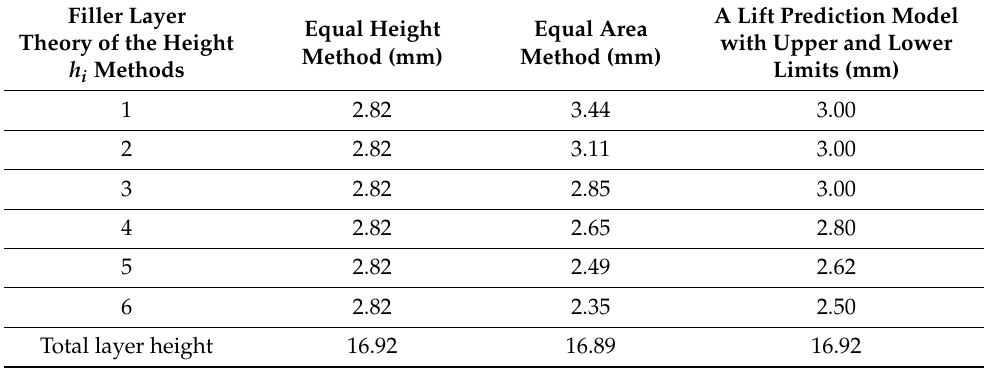
Table 2. The theoretical fill layer height of the three calculation methods. Filler